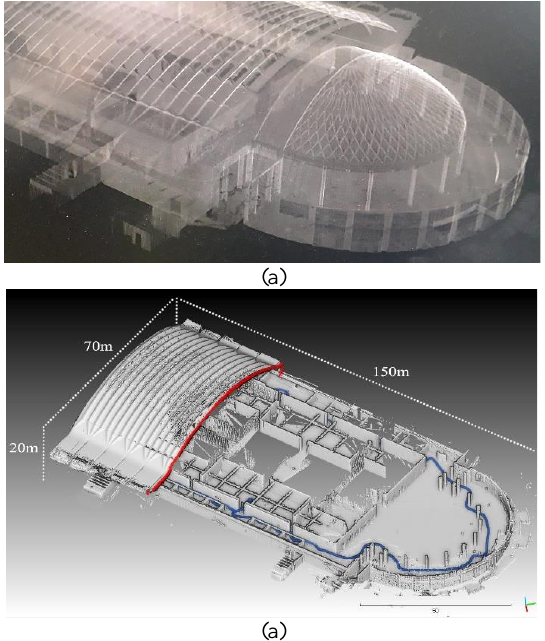
Figure 3. The preview of the Swift data on the Torino Esposizioni, hall B, with indication of the main dimensions. Table 1. Synthetic description of the three trajectories